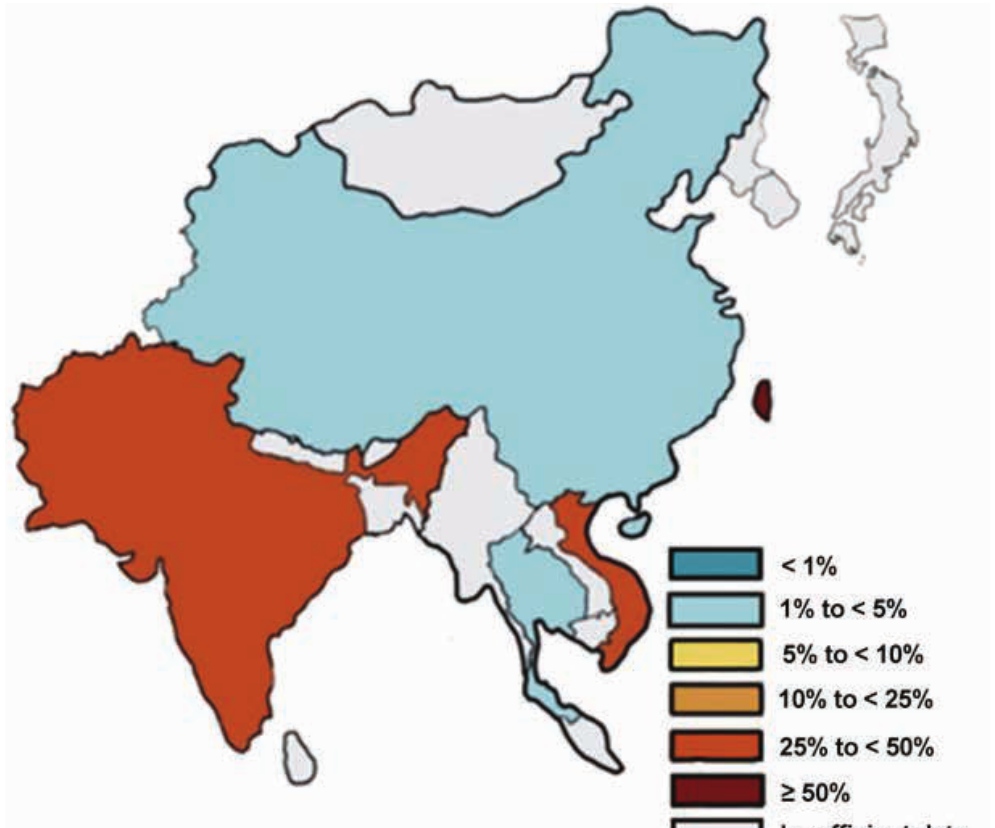
Figure 7: Map of Southeast Asia with a percentage of vancomycin resistant strains from the total number of isolates in species E. faecium in